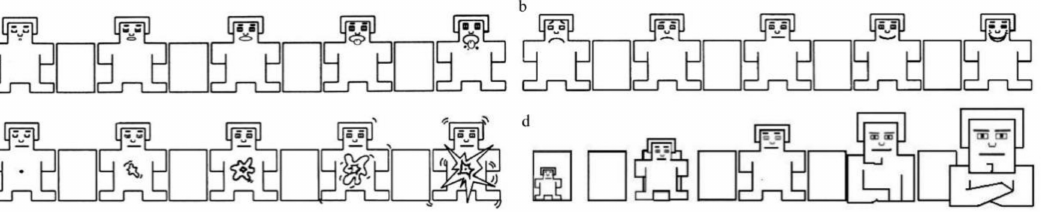
Figure 1. Self-Assessment Manikin (SAM): ( a ) wanting, ( b ) valance, ( c ) arousal, and ( d )